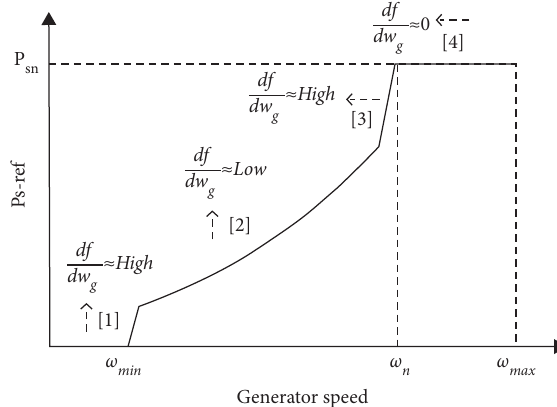
Figure 3: Speed-power curve of